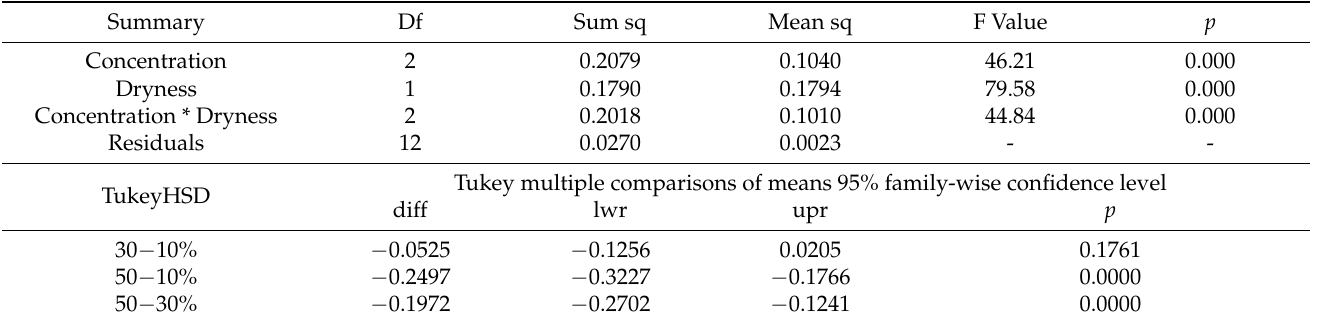
Table 7. Summary of factor importance and Tukey HSD results (ARI).